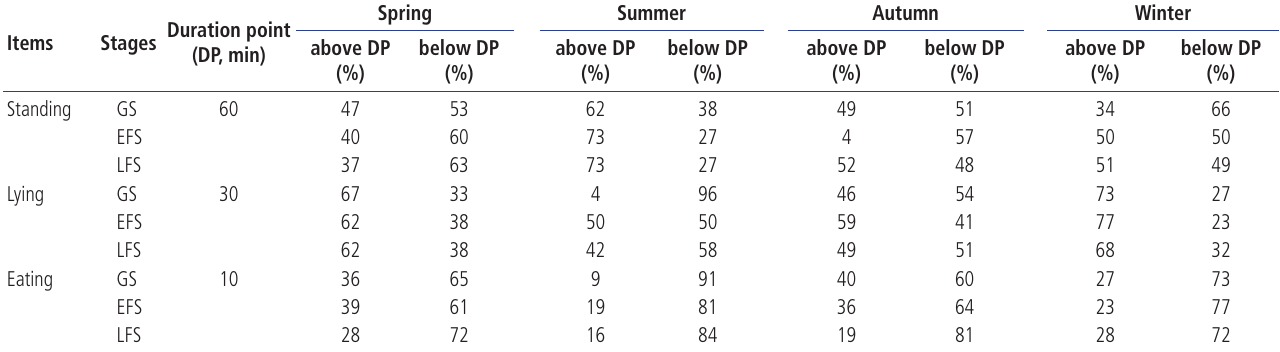
Table 6. The percentage (%) of the bout frequency in accordance with duration point (DP) under different growth stages and seasons in Hanwoo steers (n = 108) Spring Summer Autumn Duration point Items Stages (DP, min)